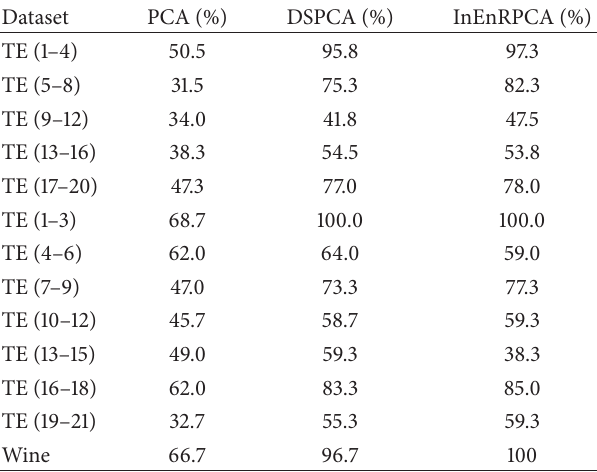
Table 4: The classifying accuracy rate for each